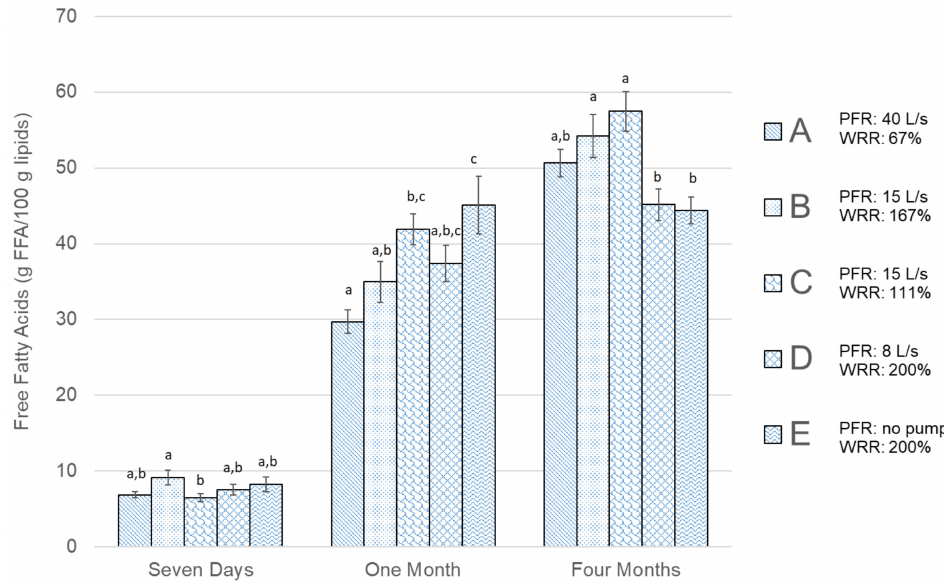
Figure 2. Free fatty acids (g FFA / 100 g lipids) results for all groups shown in Table 1. The error bars show the standard error of the mean values ( µ ± σ µ ), n = 6. Di ff erent letters (a, b, and c) within storage times represent significant di ff erences between experimental groups ( p < 0.05).